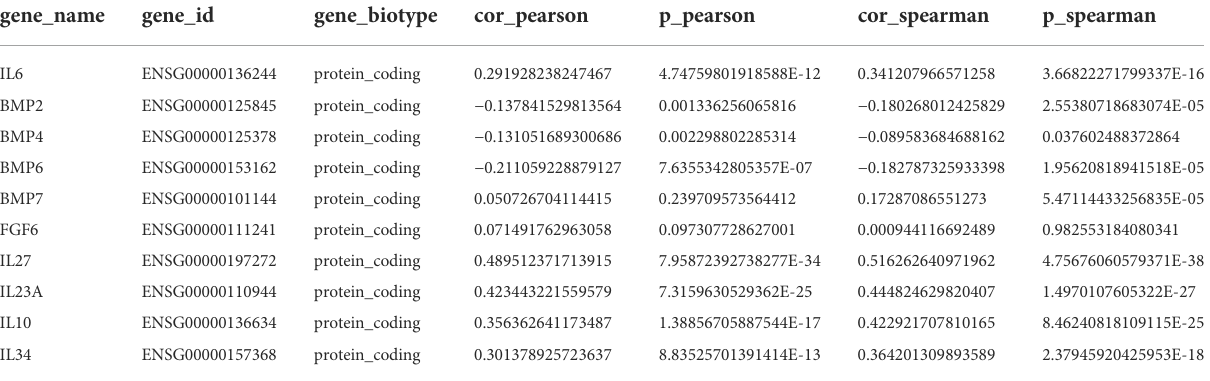
TABLE 2 Correlation of HAMP expression with selective cytokines in ccRCC